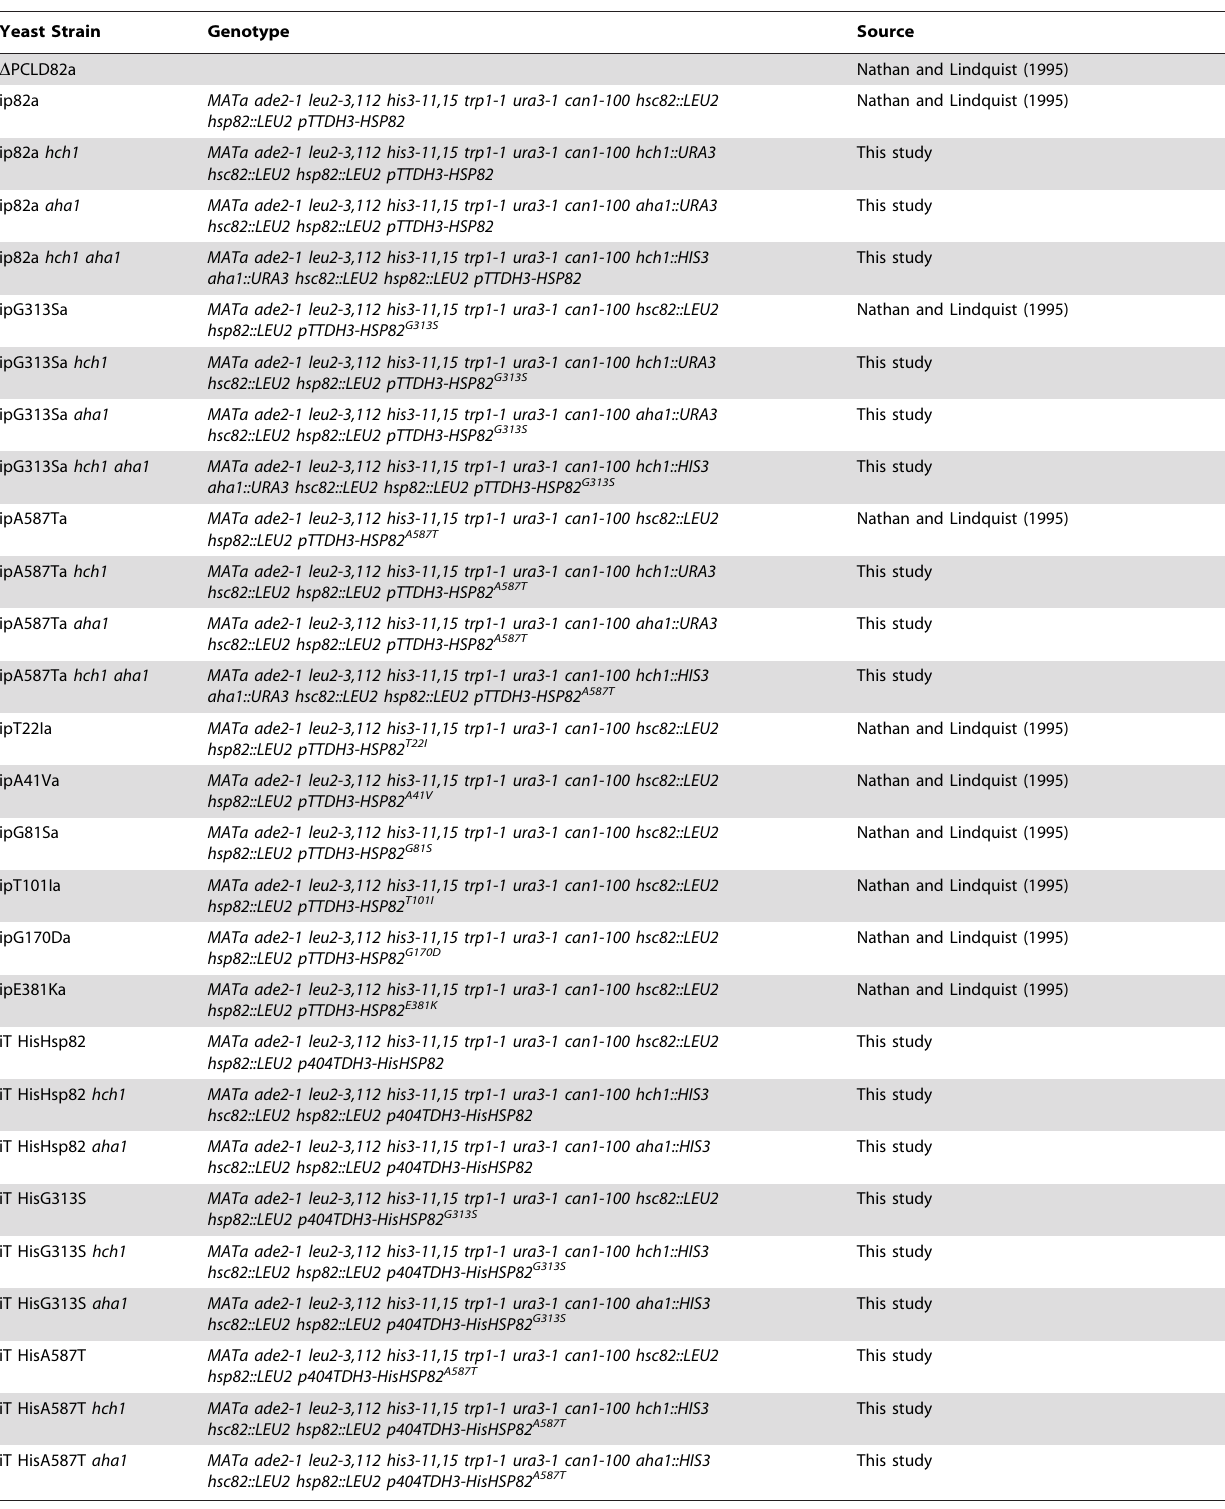
Table 1. Yeast strains used in this study.